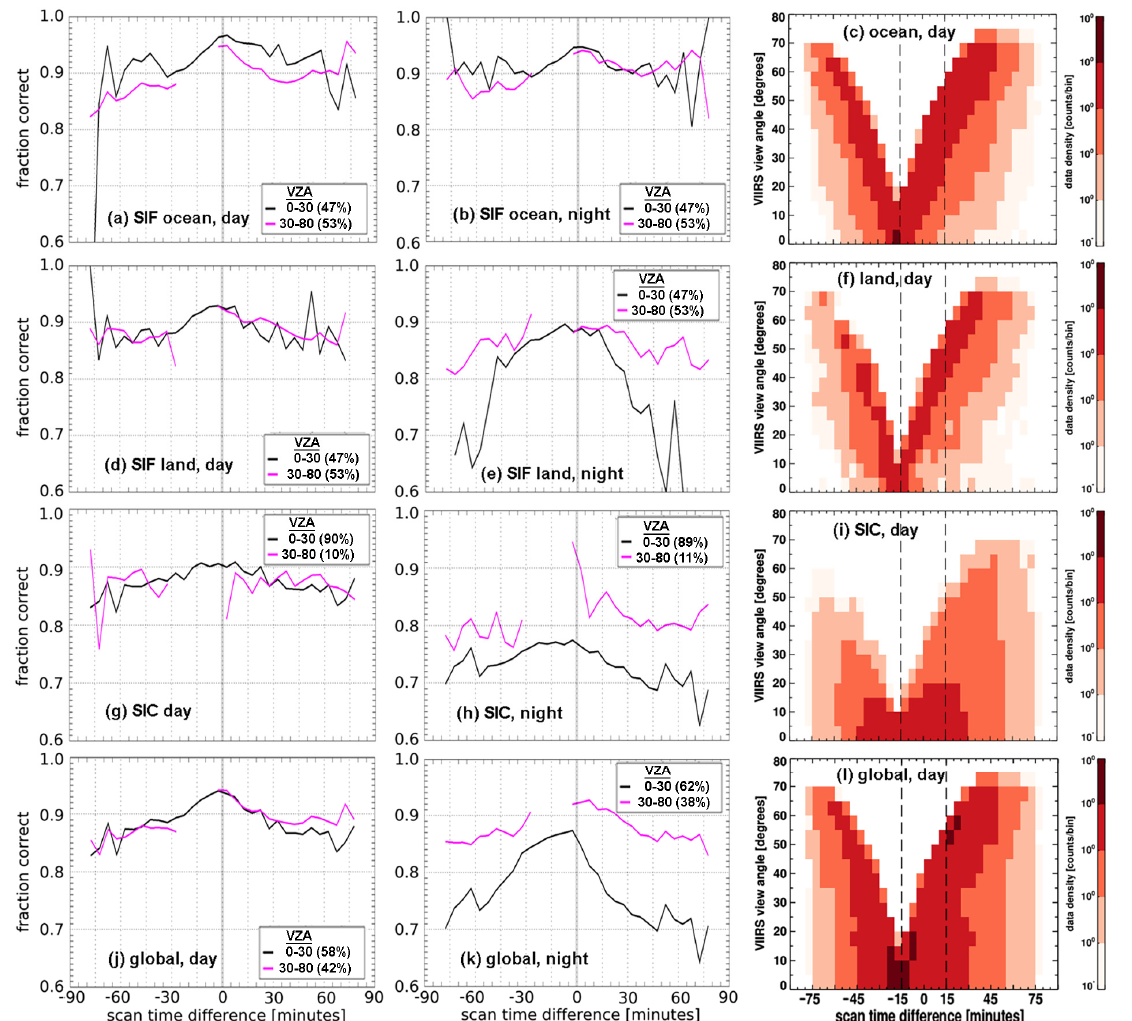
Figure 10. Cloud-clear detection FC as function of collocation time window and VIIRS VZA for 0/100 cases, JAJO 2015–2016. Mean values are shown for low VZA (0–30°) in black and high VZA (30–80°) in magenta for day ( a , d , g , j ) and night ( b , e , h , k ). Sampling density ( c , f , i , l ) is presented as function of scan time difference and VZA in the ( c , f , i , l ).